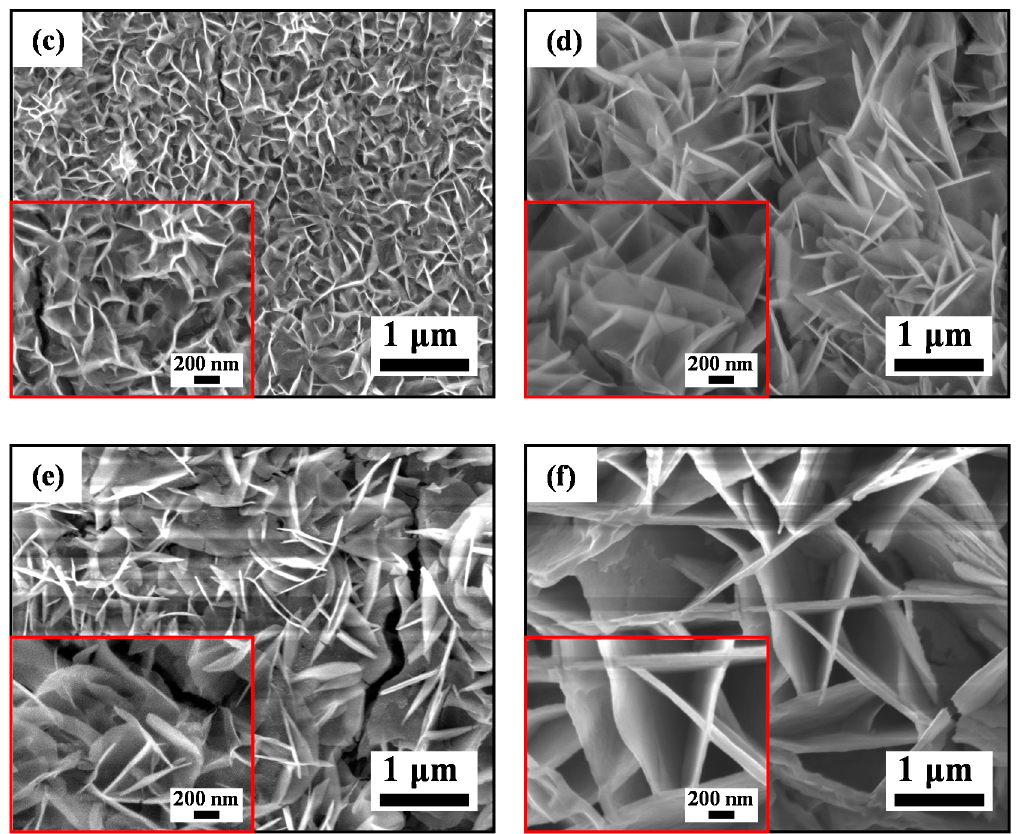
Figure 8. SEM micrographs of ( a ) H 2 O 2 = 0 mM, ( b ) H 2 O 2 = 0.5 mM, ( c ) H 2 O 2 = 5 mM, ( d ) H 2 O 2 = 10 mM, ( e ) H 2 O 2 = 30 mM and ( f ) H 2 O 2 = 50 mM for the as-spun Zr1 ribbons after reacted with MB solution. The insets in ( a – f ): the high-magnification images. Table 3. EDS analysis of the Zr1 ribbon reacted with MB solution at different H 2 O 2 concentrations (at.%).